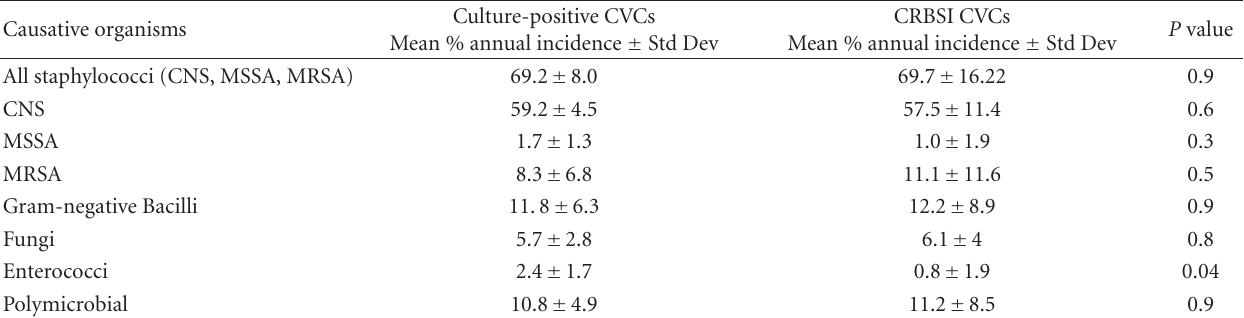
Table 3: Pattern of organisms isolated in culture-positive and CRBSI